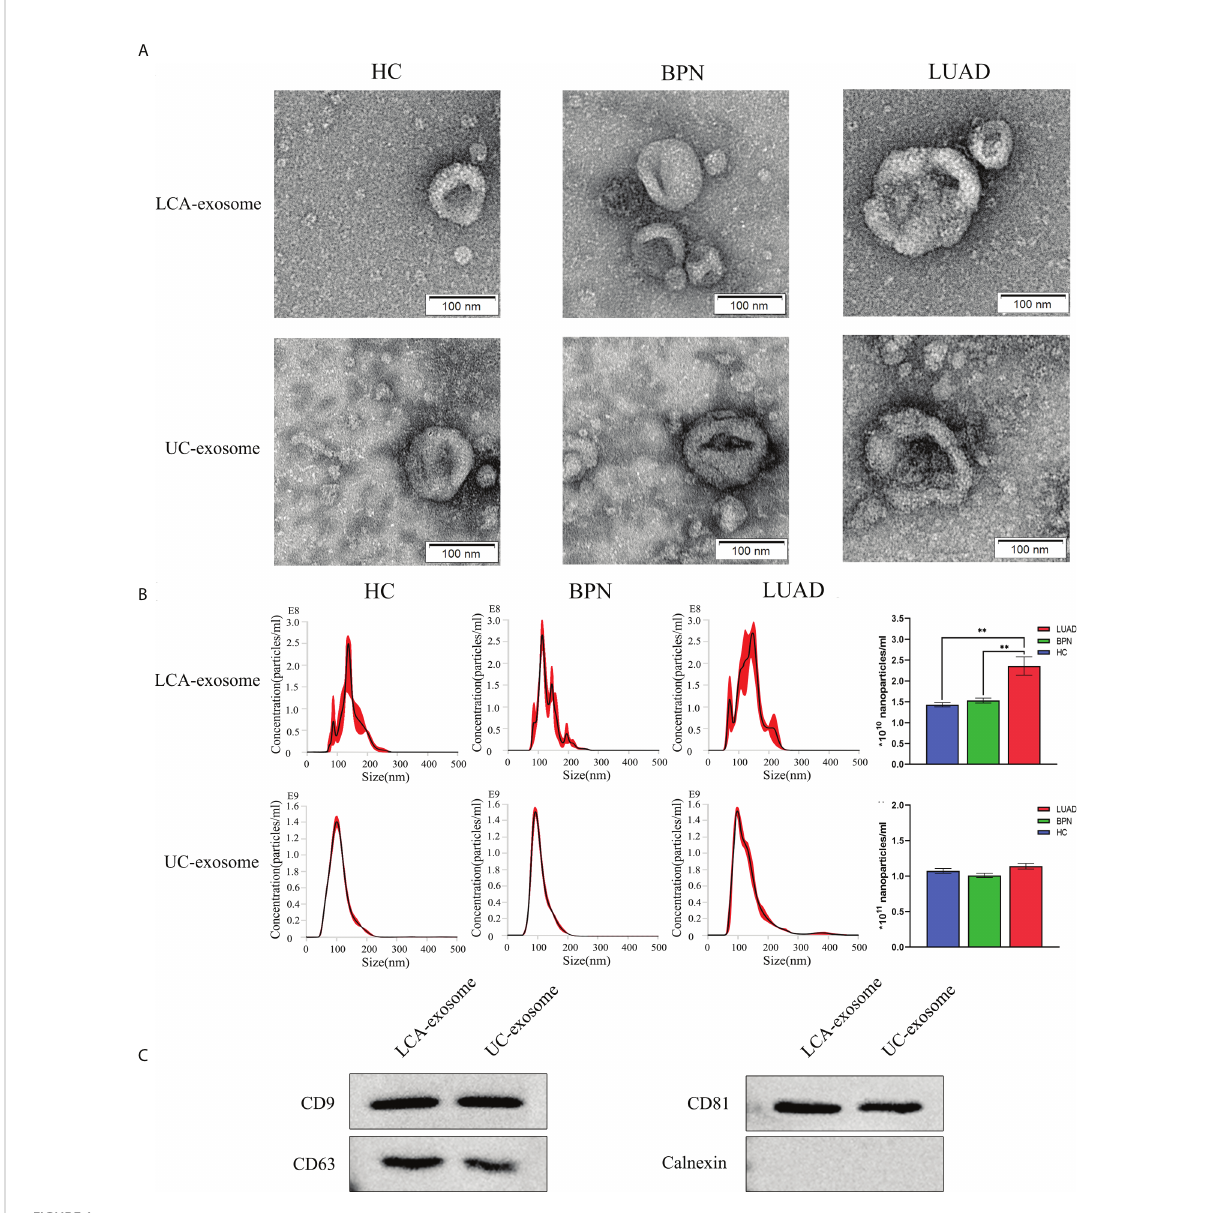
FIGURE 1 Identi fi cation of serum-derived exosomes isolated by LCA and UC methods. (A) Representative TEM images of exosomes isolated by LCA and UC methods; scale bars are 100 nm. (B) Representative graph of exosome concentration and size distribution as measured by NTA. Unpaired t-test was performed; ** P < 0.01 vs. Other group. (C) Western blot images showing the expression levels of the exosomal proteins CD9, CD63, CD81, and calnexin. LUAD, lung adenocarcinoma; BPN, benign pulmonary nodule; HC, healthy control; LCA, lentil lectin;